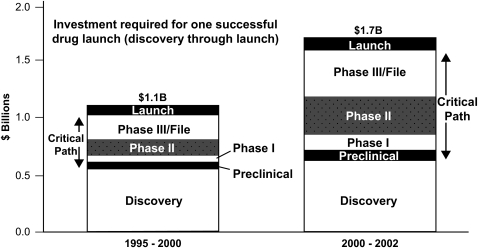
The cost of developing a successful compound is increasing, and the clinical trials pieces are the rapidly increasing components (Windhover’s In Vivo 2003).